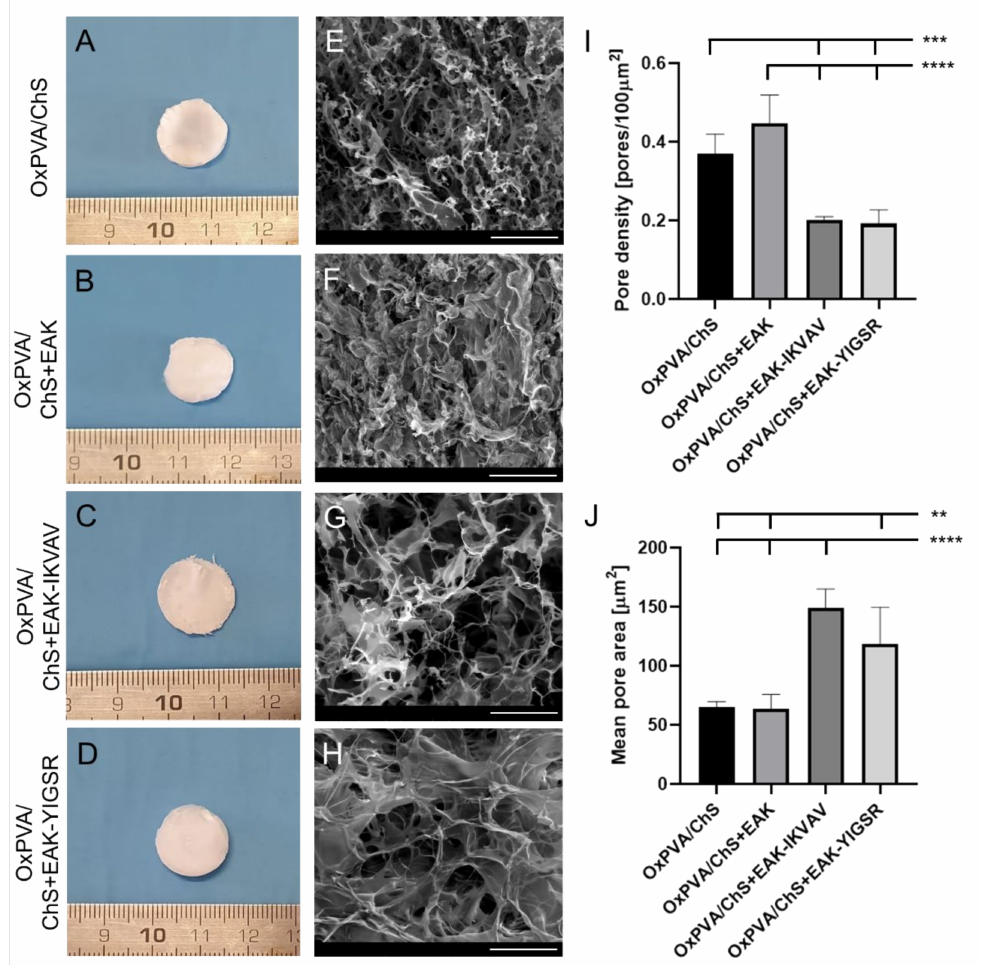
Figure 2. Macroscopic and ultrastructural features of OxPVA/ChS-based scaffolds. ( A – D ) Gross appearance of hybrid scaffolds’ seeding surfaces showing the chitosan-based layer of the supports, without/with biochemical cues (+EAK, +EAK-IKVAV, +EAK-YIGSR). ( E – H ) Ultrastructural charac- teristics of the ChS investigated by Scanning Electron Microscopy; a different fine pores interconnec- tion is identifiable, according to the specific functionalization sequences. Scale bar: 100 µ m ( E – H ). ( I ) Pore density, calculated as total pores/100 µ m 2 area (*** p < 0.001; **** p < 0.0001) and ( J ) mean pore area [ µ m 2 ] (** p < 0.01; **** p < 0.0001), by ImageJ